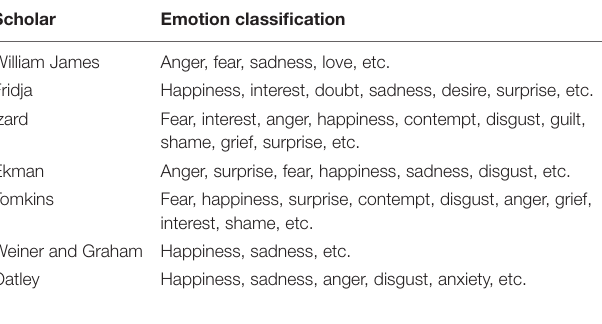
TABLE 1 | Emotion classification theories.